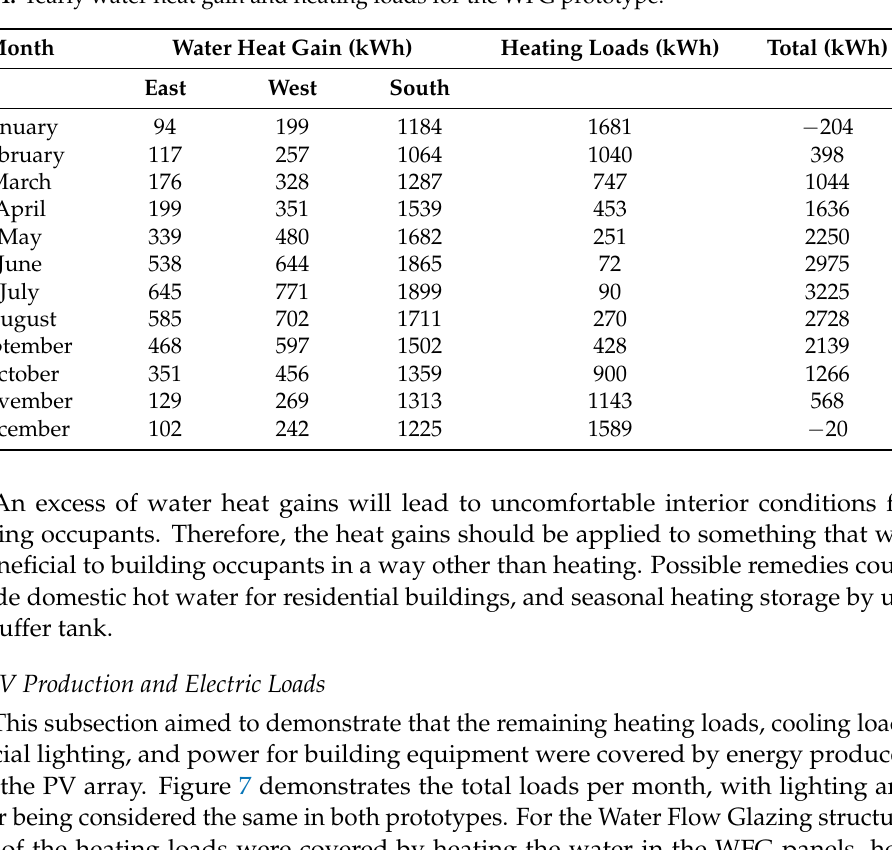
Table 4. Yearly water heat gain and heating loads for the WFG